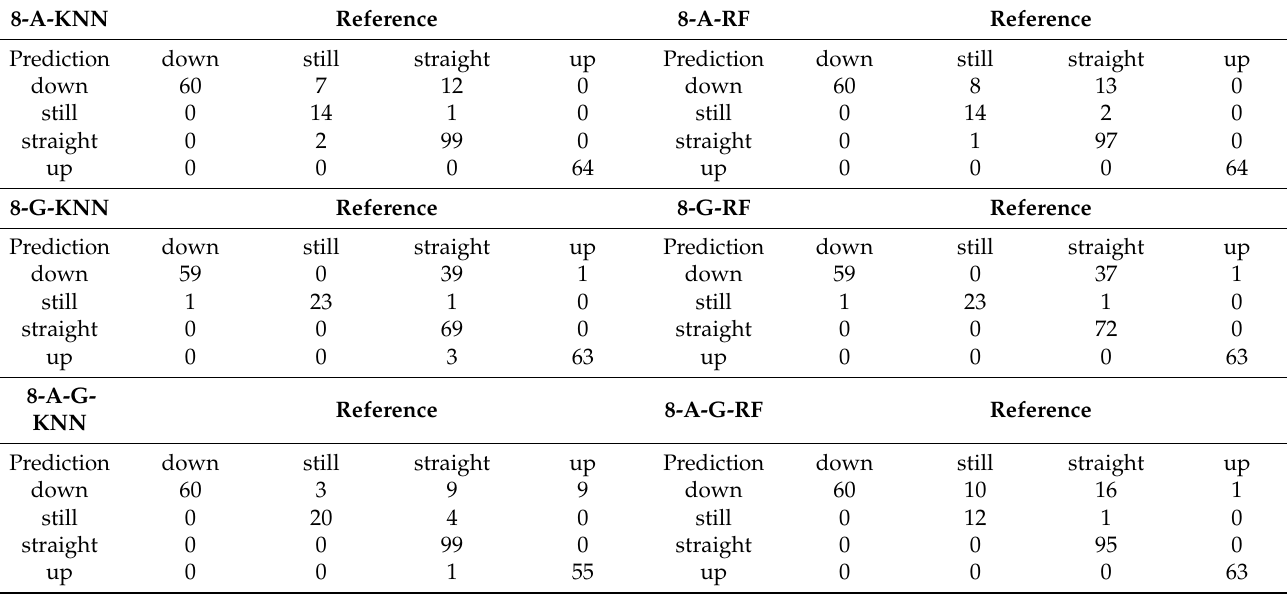
Table 3. No. 8 sensor hoisting activity recognition